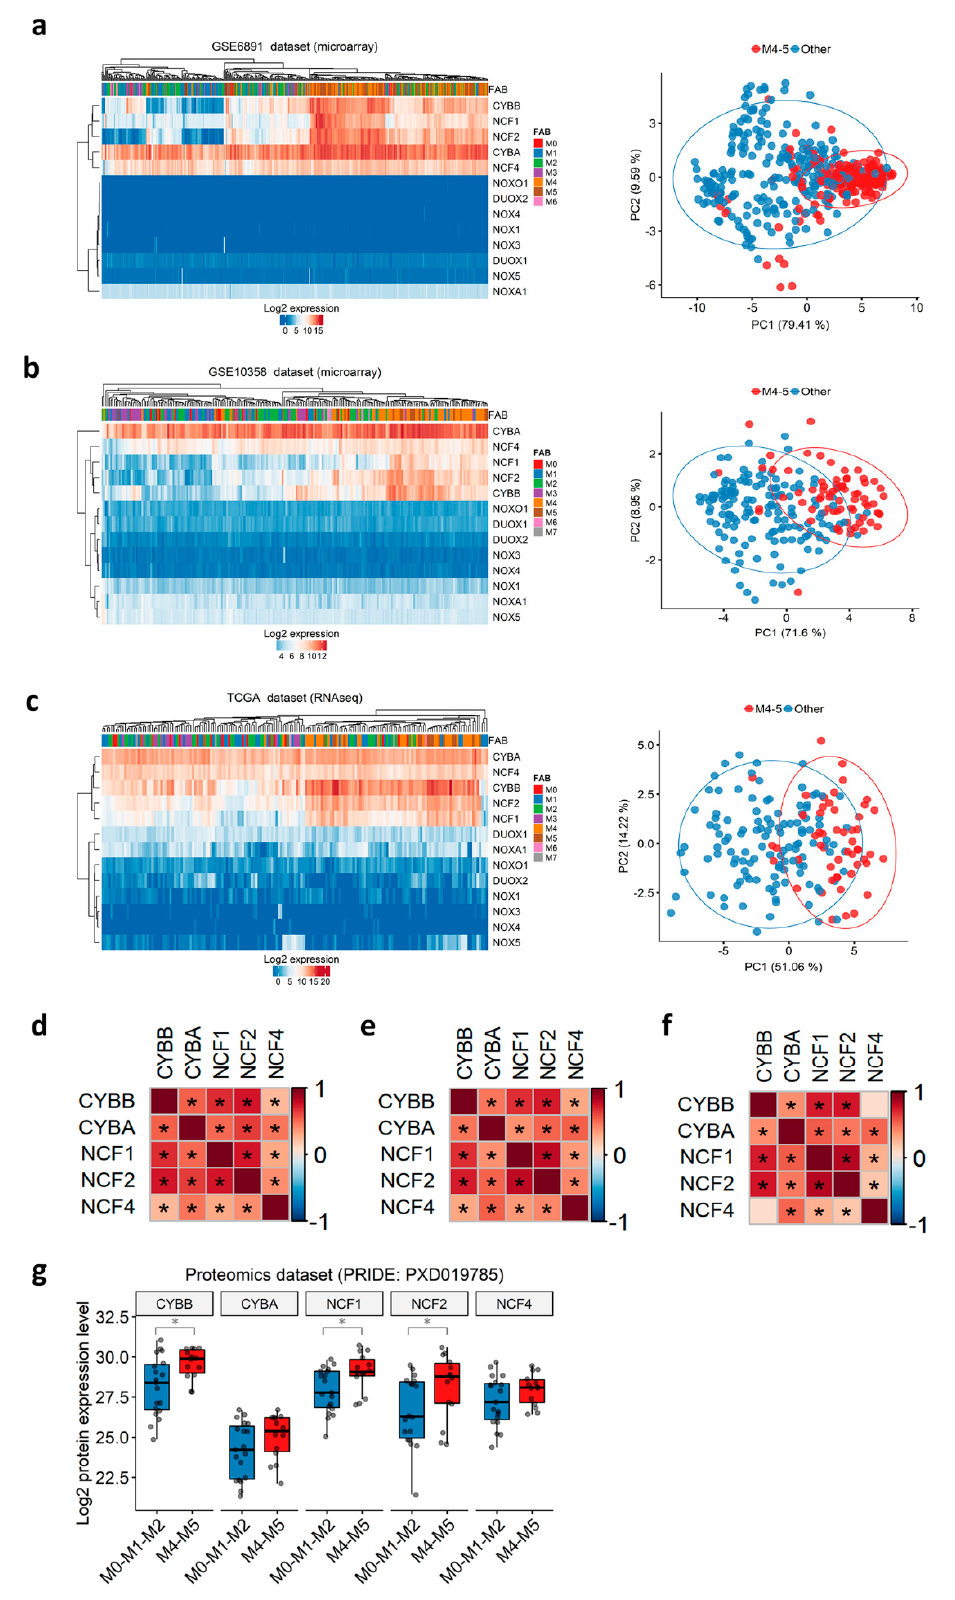
Figure 2. NOX expression profile in primary AML, according to FAB subtypes. ( a – c ) Heatmap (left) and principal component analysis (PCA) plots (right) depicting the expression of NOX genes in primary AML samples from the GSE6891, GSE10358, and TCGA datasets, respectively. In the heatmap, the data are shown as log2-expression values. Both the rows and columns are clustered using Euclidean distance and average linkage. In the PCA plot, the first two principal components explaining